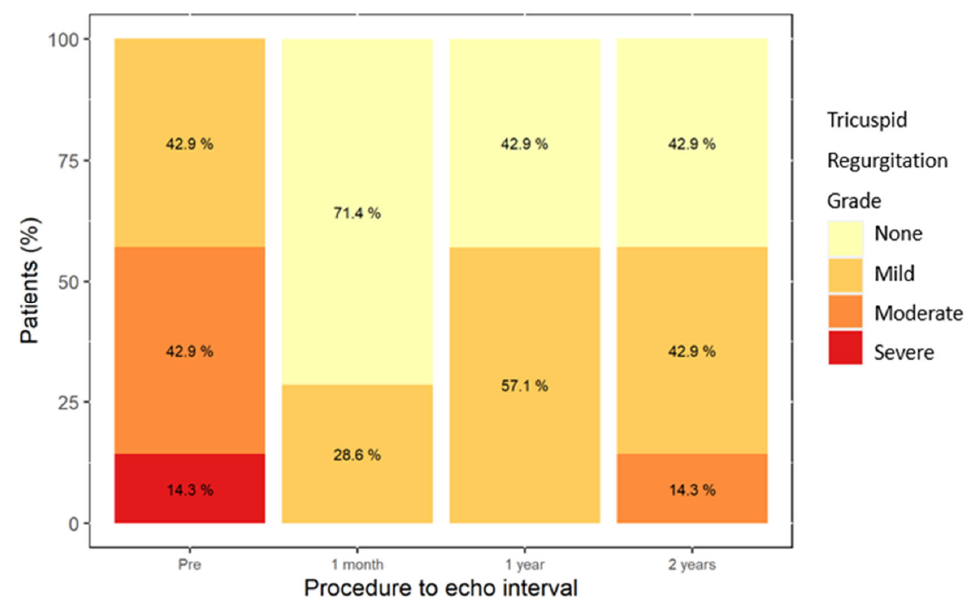
Figure 1. Severity of tricuspid regurgitation during follow-up. The mean tricuspid valve gradients decreased slightly from the pre-procedural values of 9.0 mmHg (95% CI 7.0; 12.0) to 7.0 (95% CI 5.0; 7.5) at one month following the procedure ( p = 0.36) (Figure 2). The gradients remained steady during the follow-up. There were mild or no right ventricular dysfunction measures in all patients in our cohort and this did not change over the follow-up period. This is shown in Supplementary Figure S1.